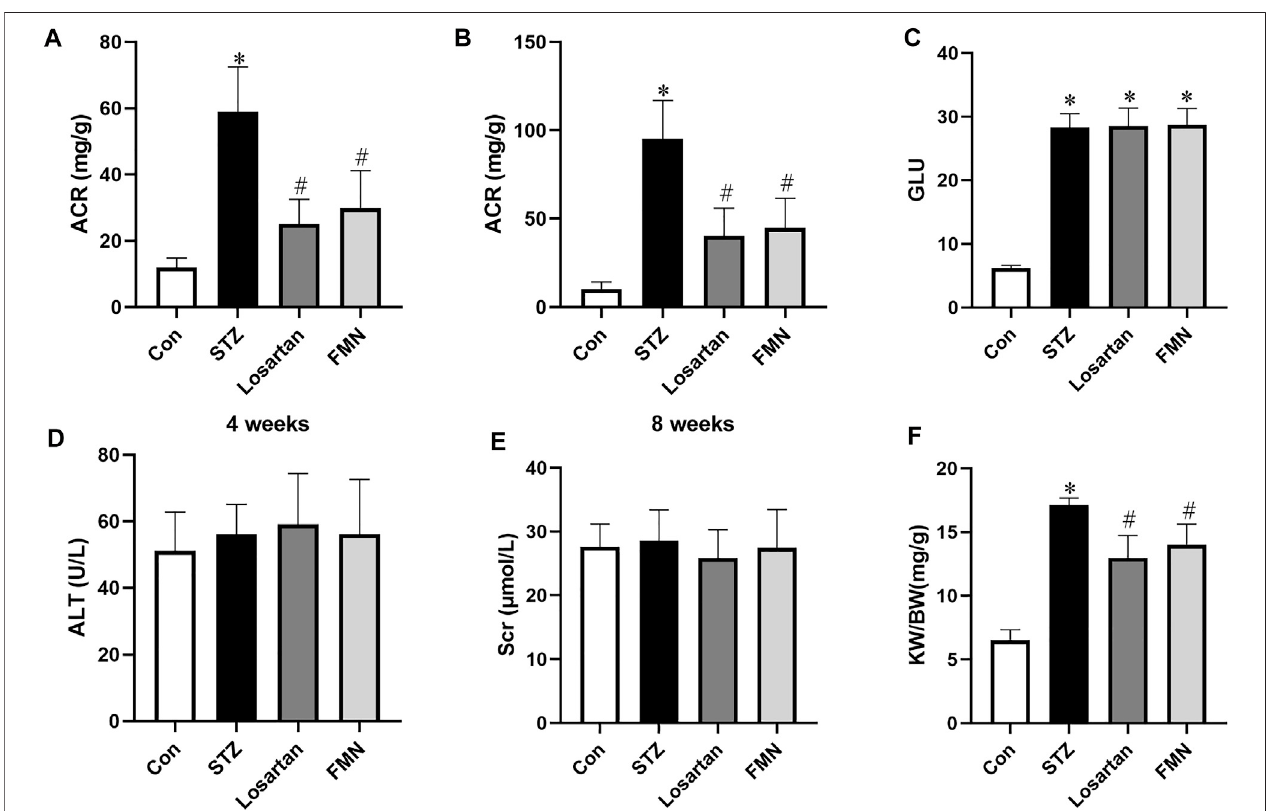
FIGURE 1 | Effects of FMN on physical and biochemical characteristics in diabetic rats. (A) ACR levels after 4 weeks of treatment. (B) ACR levels after 8 weeks of treatment.Bloodglucose(GLU) (C) ,alanineaminotransferase(ALT) (D) ,serumcreatinine(Scr) (E) andrenalindex(KW/BW) (F) levelsafter8 weeksoftreatment.Results were expressed as mean ± SD ( n = 6). * p < 0.05 vs. normal control rats. # p < 0.05 vs. STZ-induced diabetic rats.